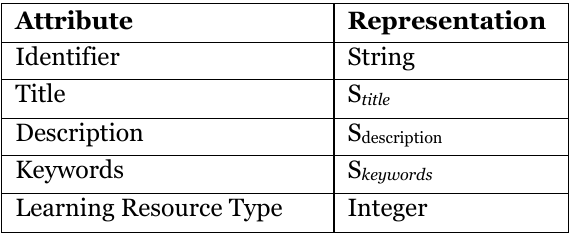
LO Attributes Present in the LOM Format